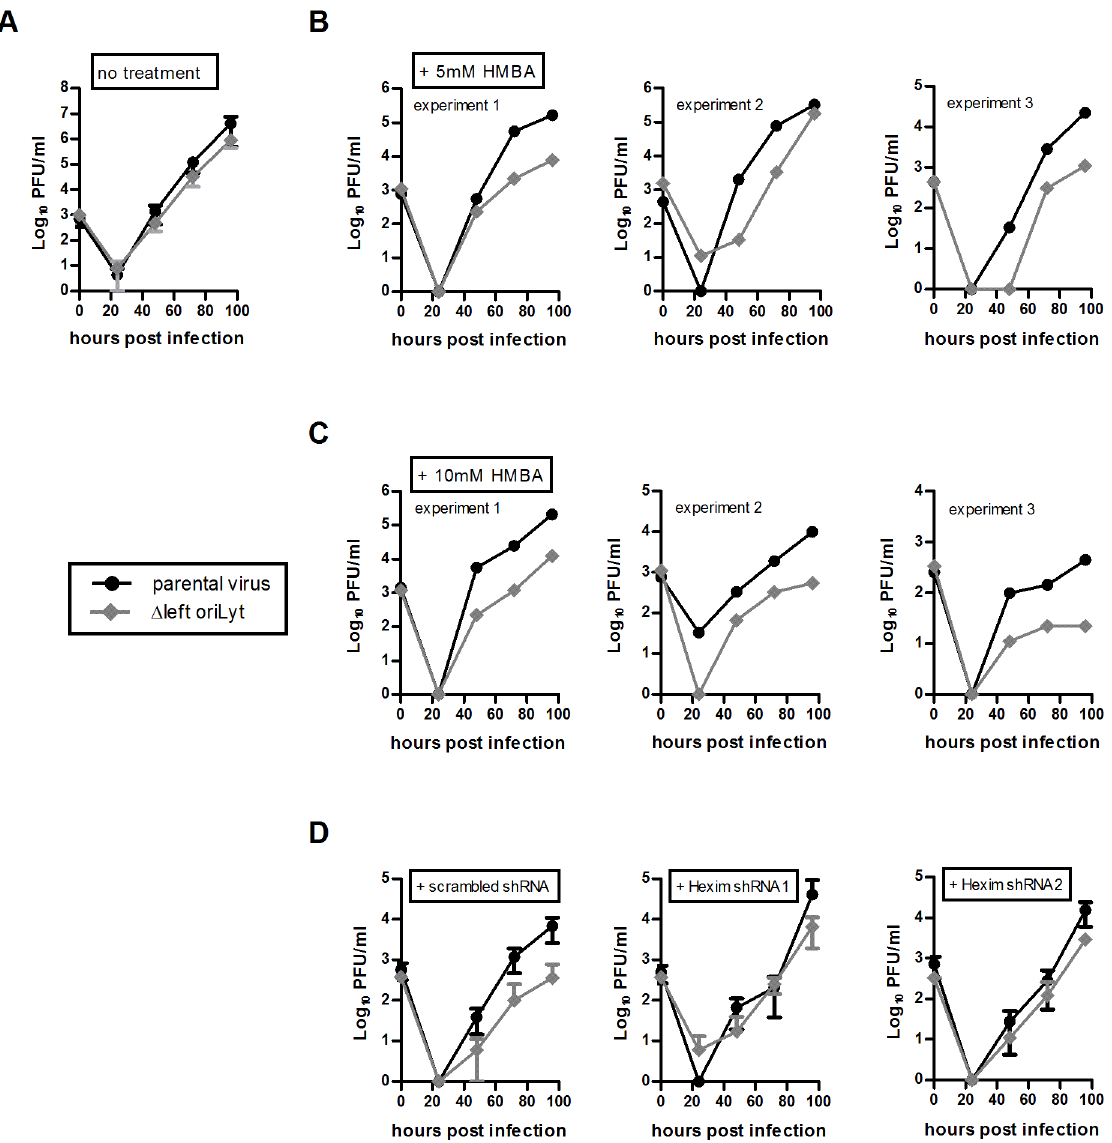
Fig 7. Virus replication in vitro after upregulation or downregulation of Hexim1. To upregulate Hexim1, NIH 3T3 cells were plated and after 4 hours stimulated with 5 mM or 10 mM HMBA or left untreated. 24 hours later, cells were infected with the indicated viruses at an MOI of 0.01 for 1 hour. After removing the inoculum, cells were incubated with fresh medium without HMBA (A), with 5 mM HMBA (B) or with 10 mM HMBA (C) at 37°C and 5% CO 2 until the supernatants together with the cells were harvested at different time points after infection. Virus titers were determined by plaque assay. For the “ no treatment ” control, the means ± SEM of duplicates from three independent experiments are shown. Data shown for the HMBA treated cells are from three independent experiments showing each single experiment. To downregulate Hexim1, TCMK-1 cells were stable transfected with two different shRNAs specific for Hexim1 or with a scrambled control shRNA, respectively (D). Cells were plated and after 24 hours infected with the indicated viruses at an MOI of 0.01 for 1 hour. After removing the inoculum, cells were incubated with fresh medium at 37°C and 5% CO 2 until the supernatants together with the cells were harvested at different time points after infection. Virus titers were determined by plaque assay. For the “ scrambled shRNA ” control, the means ± SEM of duplicates from two independent experiments are shown. For the shRNAs specific for Hexim1, the means ± SD of two independent experiments each are